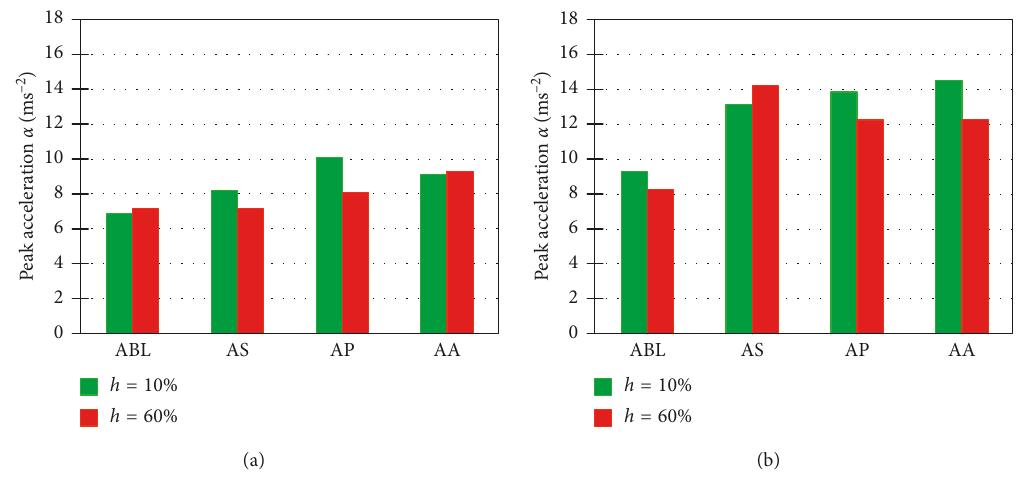
Figure 23: The effect of pebble layer moisture on peak horizontal acceleration a . (a) PGA � 0.2g. (b) PGA � 0.6